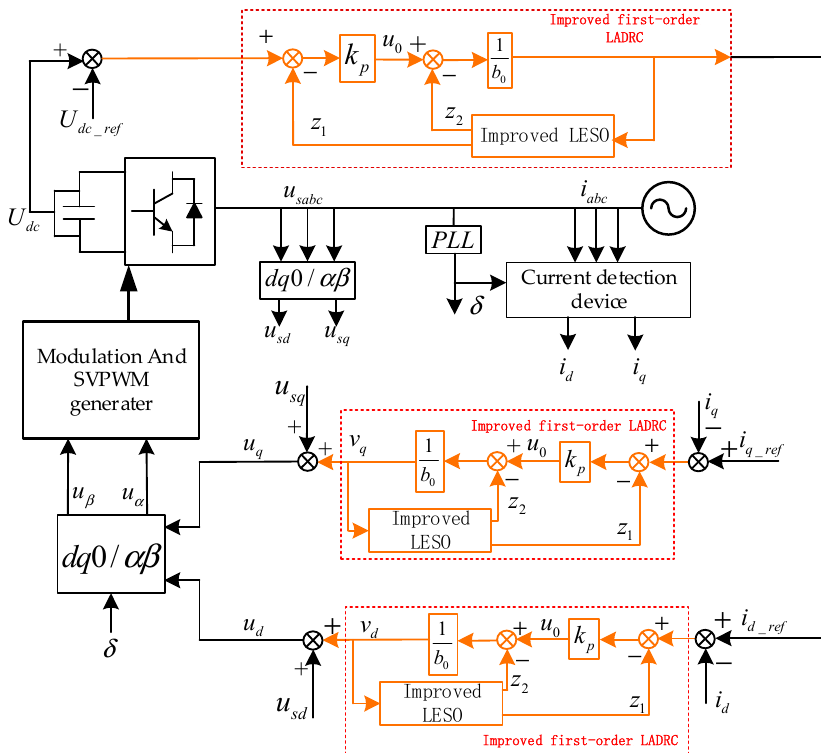
Figure5. Figure 5. The improved LADRC double closed-loop control block diagram combined with the D- STATCOM.